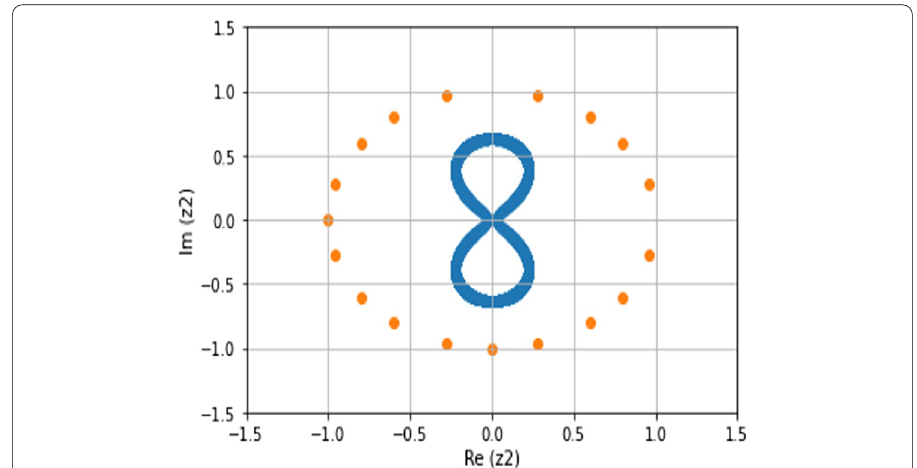
Fig. 4 Root map for the specialized second-order